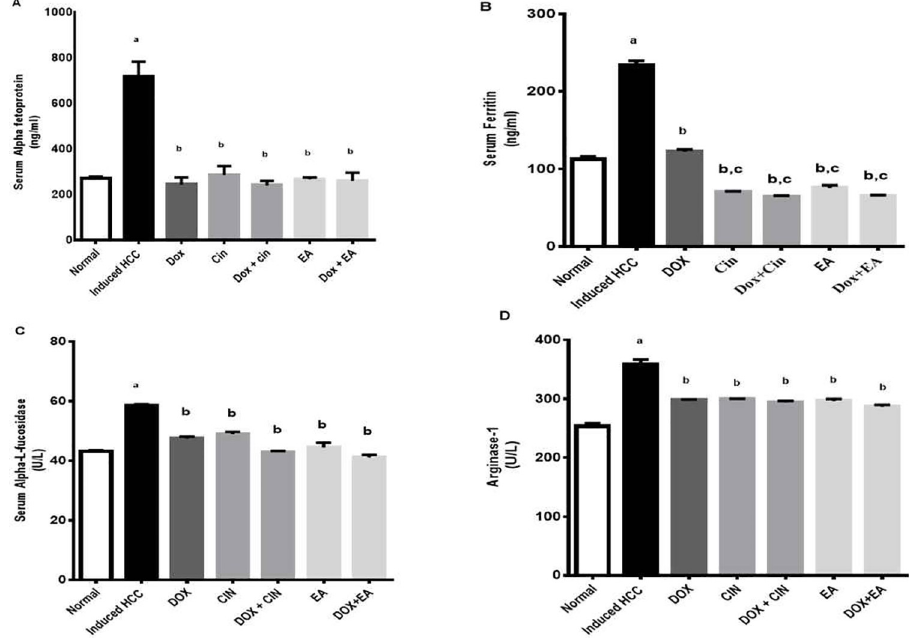
Fig 1. Effect of 1,8 cineole (Cin), ellagic acid (EA), doxorubicin (DOX), and combinations on HCC tumor markers. Serum levels of alpha-fetoprotein (A), ferritin (B), Alpha-L-fucosidase (C) and Arginase-1(D) were measured in DEN/2-AAF-induced HCC rats using ELISA kits. Data are presented as mean ± S.E.M, n = 10. ‘ a ’ P < 0.05 vs. normal group, ‘ b ’ P < 0.05 vs. DEN/2-AAF-induced HCC group and ‘ c ’ P < 0.05 vs. DOX treated group using one-way ANOVA followed by Tukey’s post-hoc